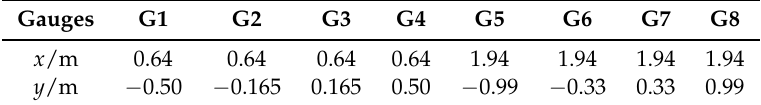
Figure 13. The experimental configuration of partial dam break flow over movable bed [16]. Table 3. Coordinates of gauges for experiment of partial dam-break flow over mobile